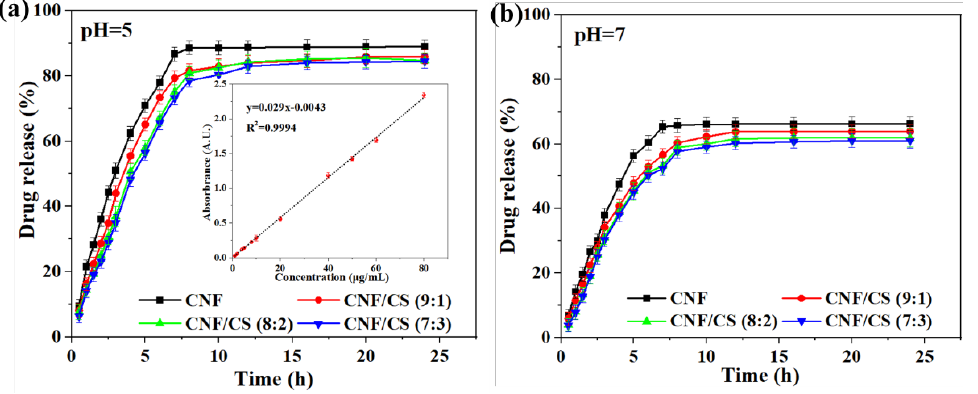
Figure 5. Release curves of CNF and CNF/CS beads under pH = 5 ( a ) and pH = 7 ( b ), the insert image is a standard concentration curve of TH.